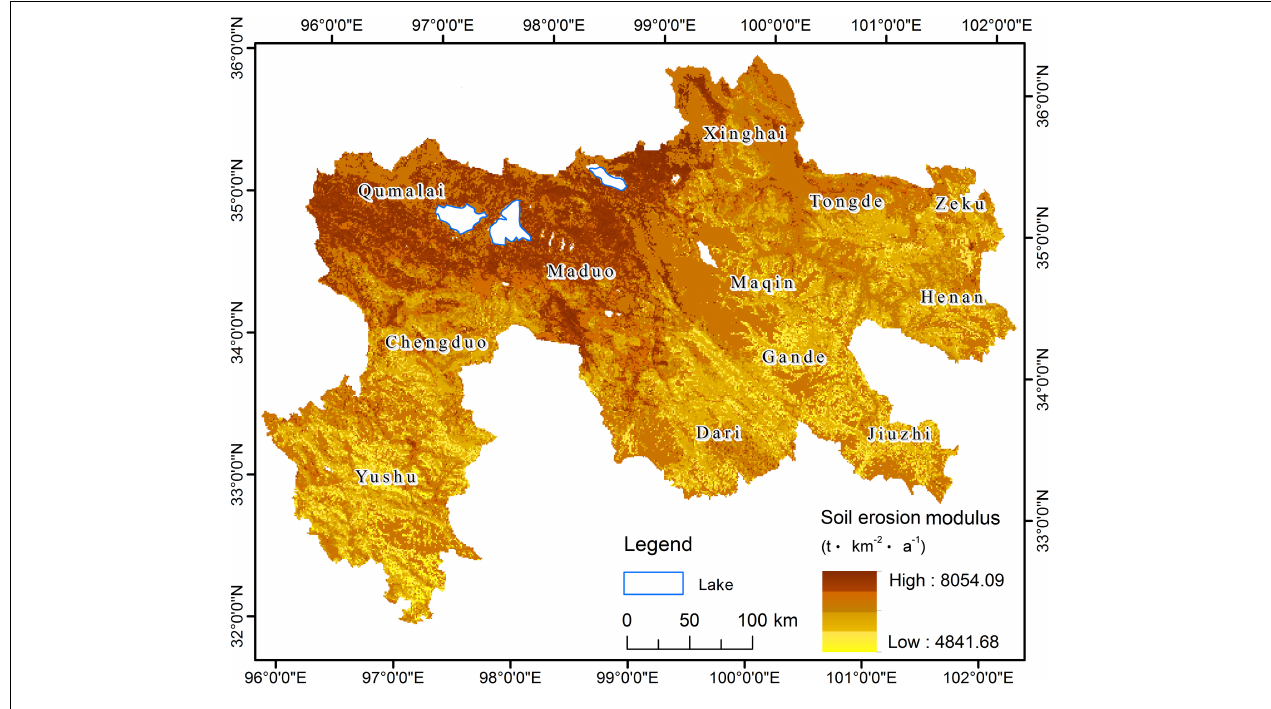
FIGURE 4 | The spatial distribution of the soil erosion